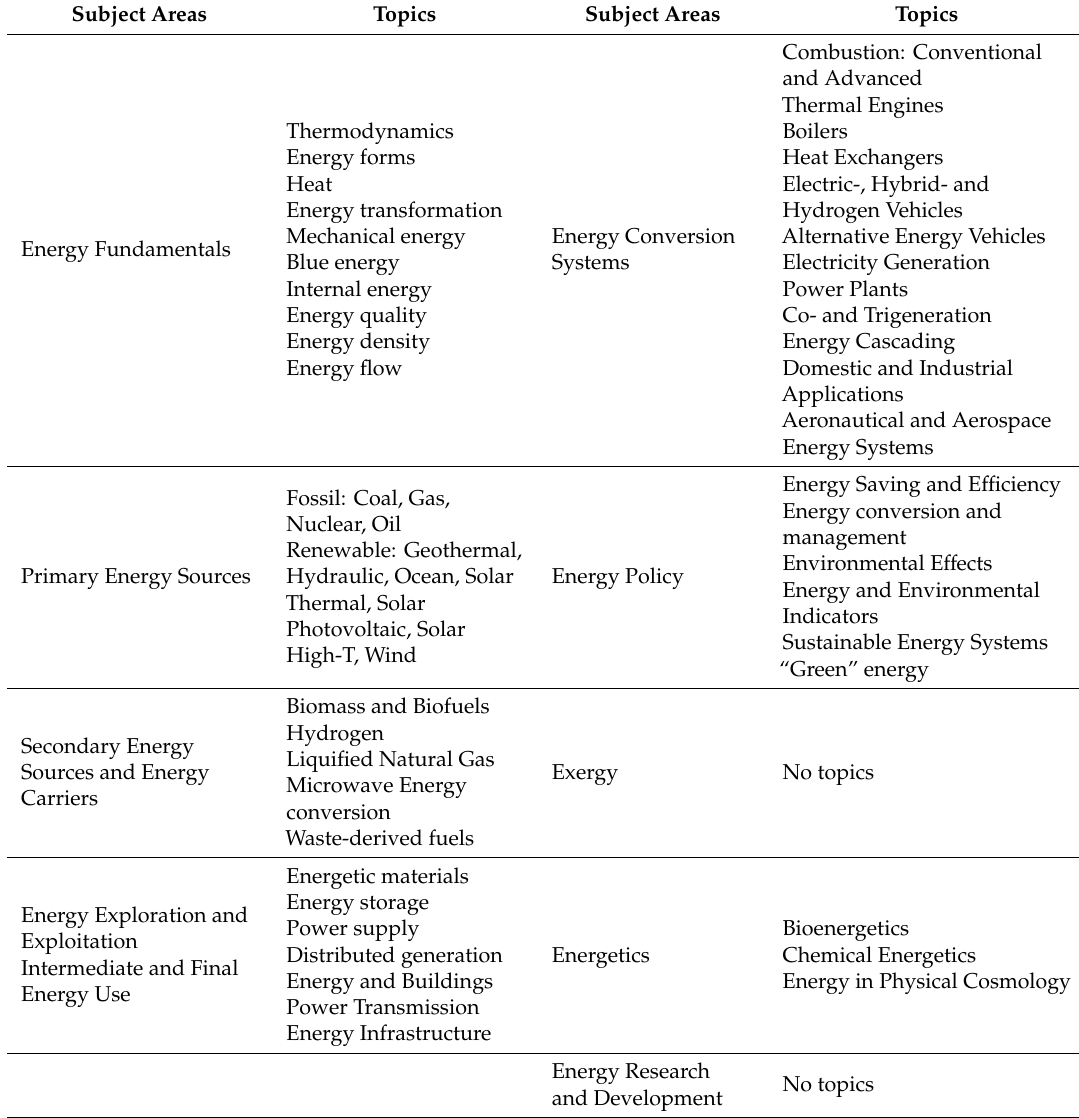
Table 1. Subject Areas in journal MDPI Energies